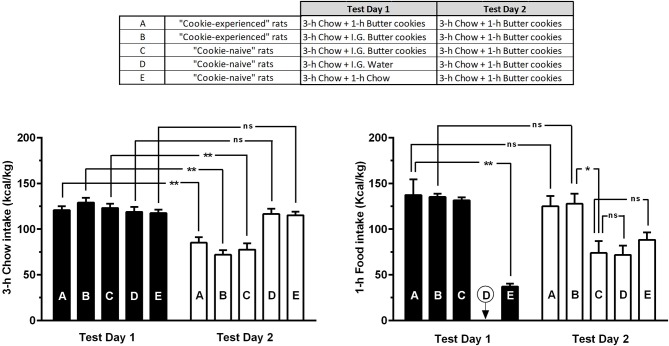
Intake of calories from chow or butter cookies in “cookie-experienced” and “cookie-naive” rats on the 2 test days of Phase 3 of Experiment 1. On Test Day 1, “cookie-experienced” rats were initially exposed to a 3-h chow-feeding session and then either exposed to a 1-h cookie-feeding session (Subgroup A) or given intragastrically an equivalent amount of cookies (Subgroup B); the day after (Test Day 2), both rat subgroups (A and B) were initially exposed to a 3-h chow-feeding session and then to a 1-h cookie-feeding session. On Test Day 1, “cookie-naive” rats were initially exposed to a 3-h chow-feeding session and then treated intragastrically with either cookies (Subgroup C) or water (Subgroup D) or exposed to a 1-h chow-feeding session (Subgroup E); the day after (Test Day 2), all 3 rat subgroups (C-E) were initially exposed to a 3-h chow-feeding session and then to a 1-h cookie-feeding session. Each bar is the mean ± SEM of n = 12 rats. *P < 0.005 and **P < 0.0001 (Šidák test). “ns” stands for “non-significant”.